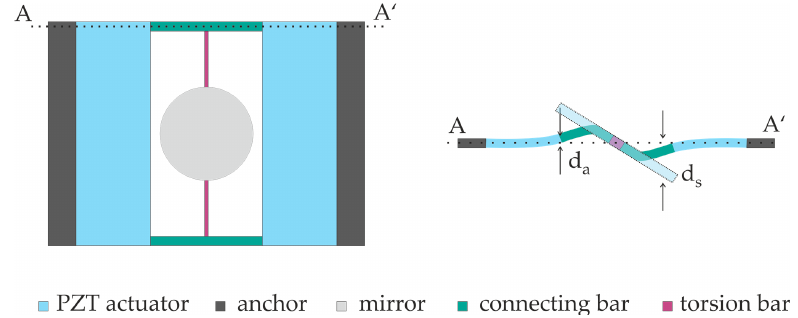
Figure 1. Top view and cross-sectional view of the basic design S. AA’: Cross-section of actuators and connecting bars, d a stands for displacement of actuators and d m stands for displacement of mirror plate. Actuators, mirror plate, torsion bars and connecting bars can be sorted into two groups: The torsion bars and mirror plate constitute the torsion group (Group T), while the actuators and connecting bars constitute the bending group (Group B). These two groups behave as two coupled